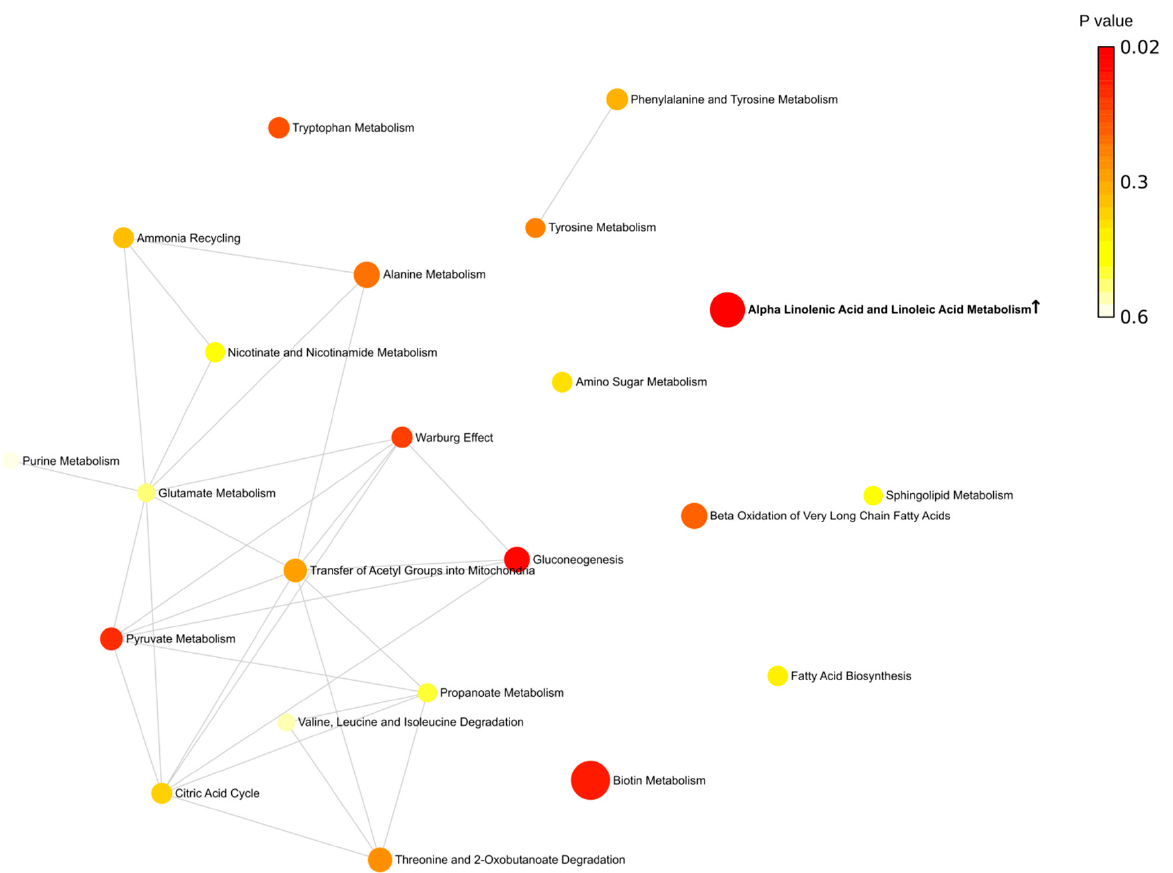
Figure 8. Metabolic pathways enriched in winter. Bold indicates significantly enriched pathways ( p < 0.05). ↑ —increased serum level of metabolites included in the metabolic pathway in MS compared to control; ↓ —decreased serum level of metabolites included in the metabolic pathway in MS com ‐ pared to control. Each node represents a metabolite set with its color based on its p value and its size based on fold enrichment. Two metabolite sets are connected by an edge if the number of their shared metabolites is over 25% of the total number of their combined metabolite sets. The yellow to red color gradient and larger size of the circle indicate lower p value.